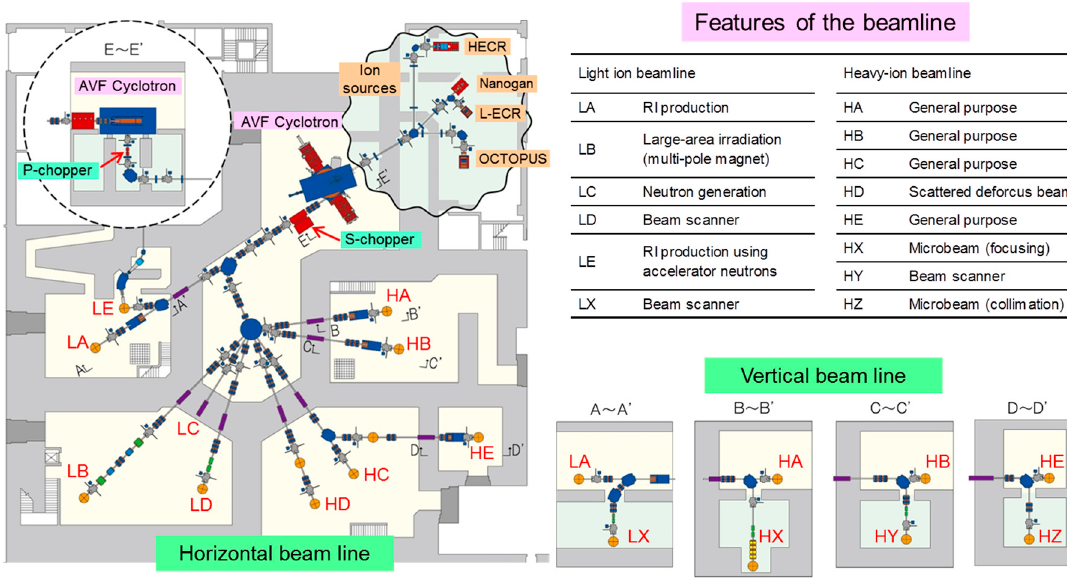
Figure 8. Layout of the ion sources, the cyclotron, and the beam transport lines, including ten horizontal and four vertical lines.